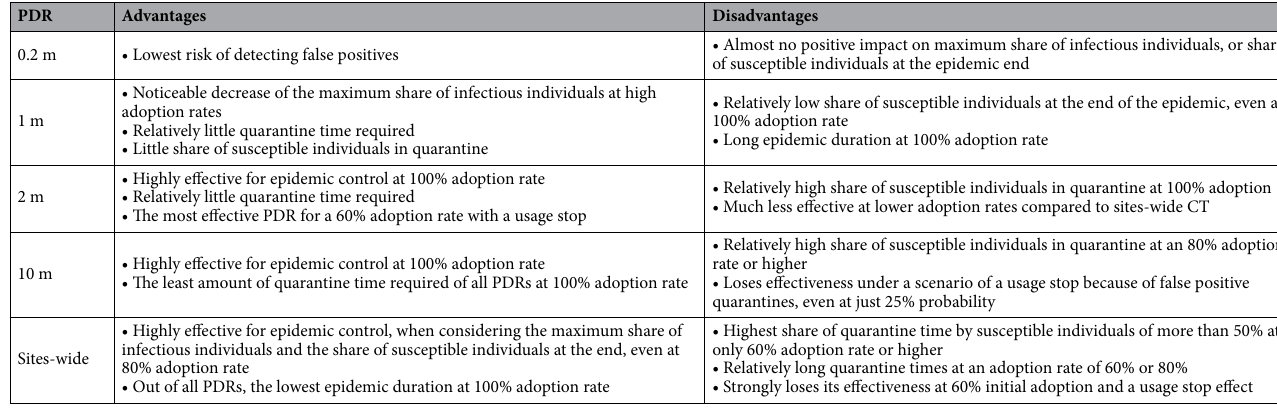
Table 2. Simulated PDRs and their advantages and disadvantages for